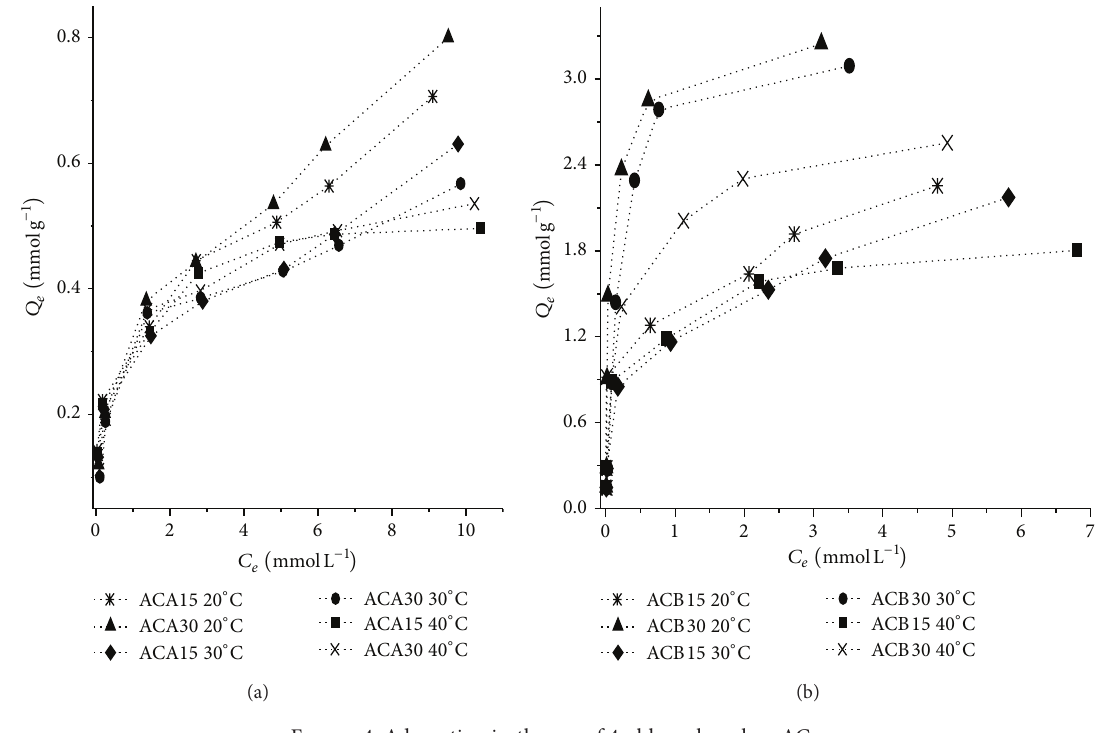
Figure 4: Adsorption isotherms of 4-chlorophenol on ACs. Table 2: Langmuir, Freundlich, and Dubinin-Raduskevich-Kaganer models parameter for the adsorption of phenols on ACs at 20 ∘ C.